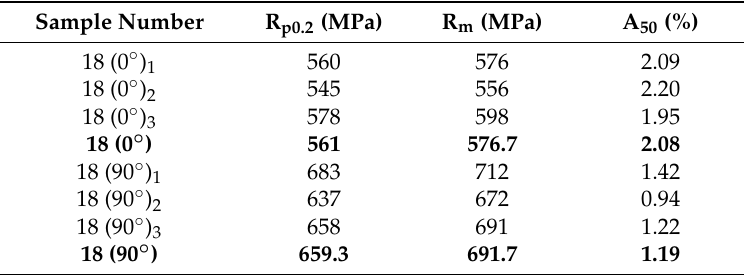
Table 3. Mechanical properties of material identified by uniaxial tensile test (test specimen No. 18): the bold represents average value.